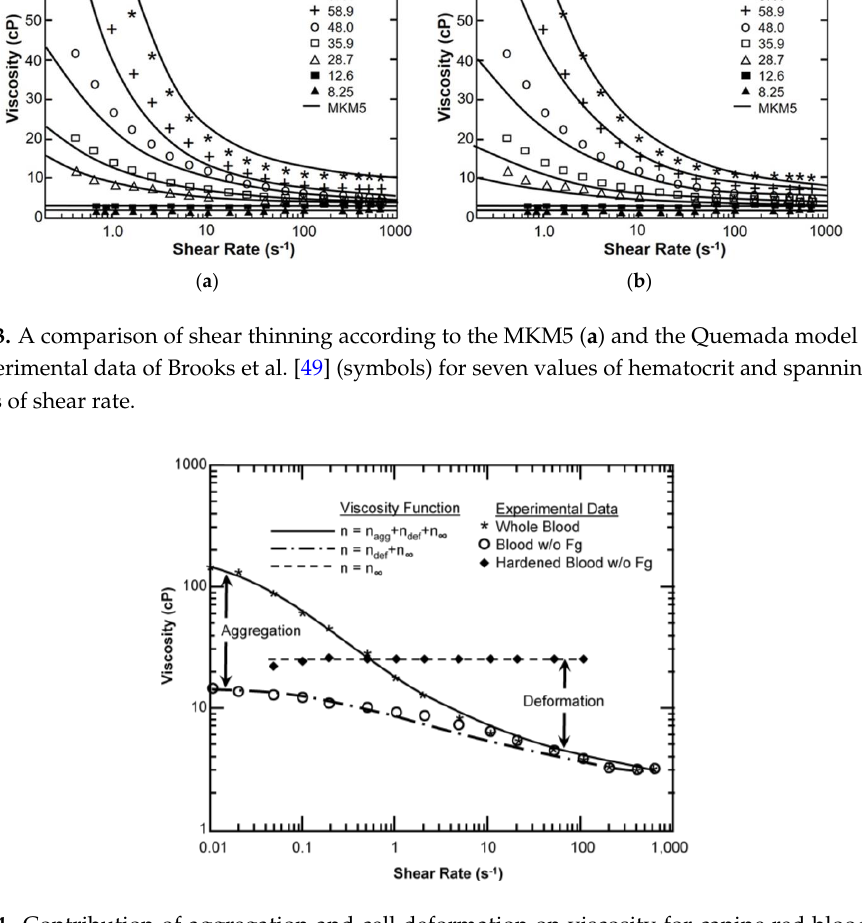
Figure 4. Contribution of aggregation and cell deformation on viscosity for canine red blood cells (RBCs) at a hematocrit of 45% and a temperature of 37 °C. The lines for each case are generated from the modified Krieger model with the appropriate optimal parameters. Experimental data from Chien [50]. Fluids 2017 , 2 , 10